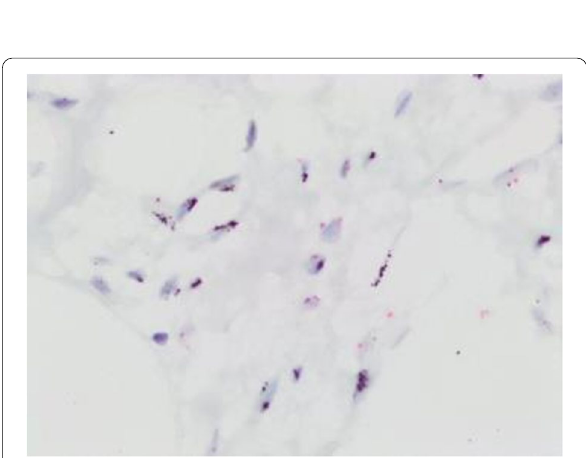
Fig. 5 MDM2 amplification by in situ hybridization (CISH, 400